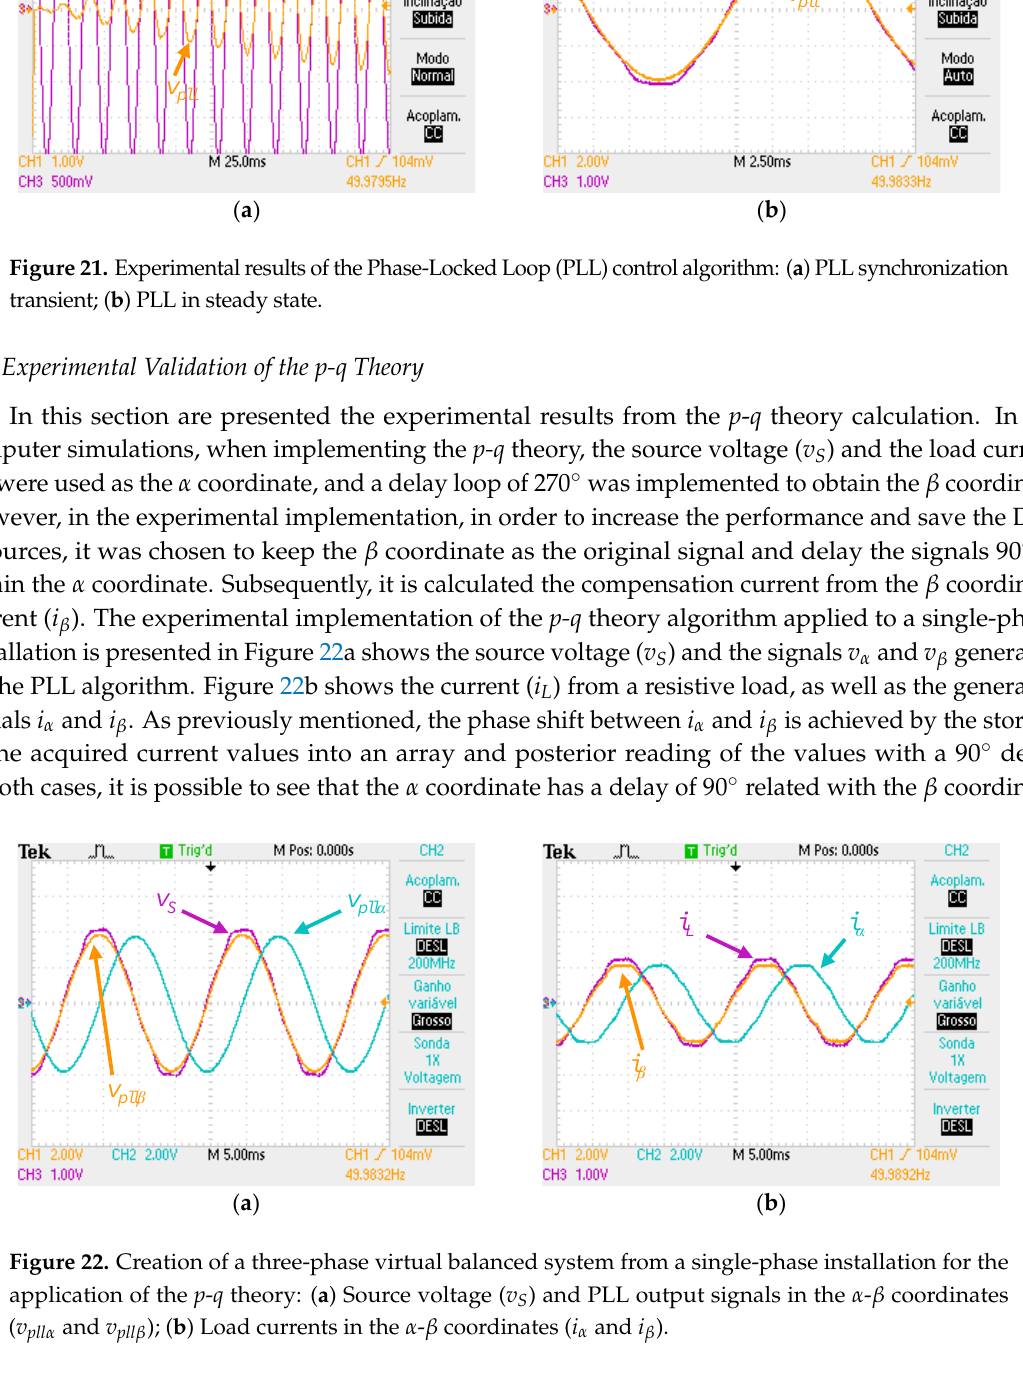
Figure 23. Validation of the p - q theory algorithm with a full-bridge diode rectifier: Load current ( i L ), compensation current calculated by the p - q theory ( i F *), and the theoretical source current after the compensation ( i S *).